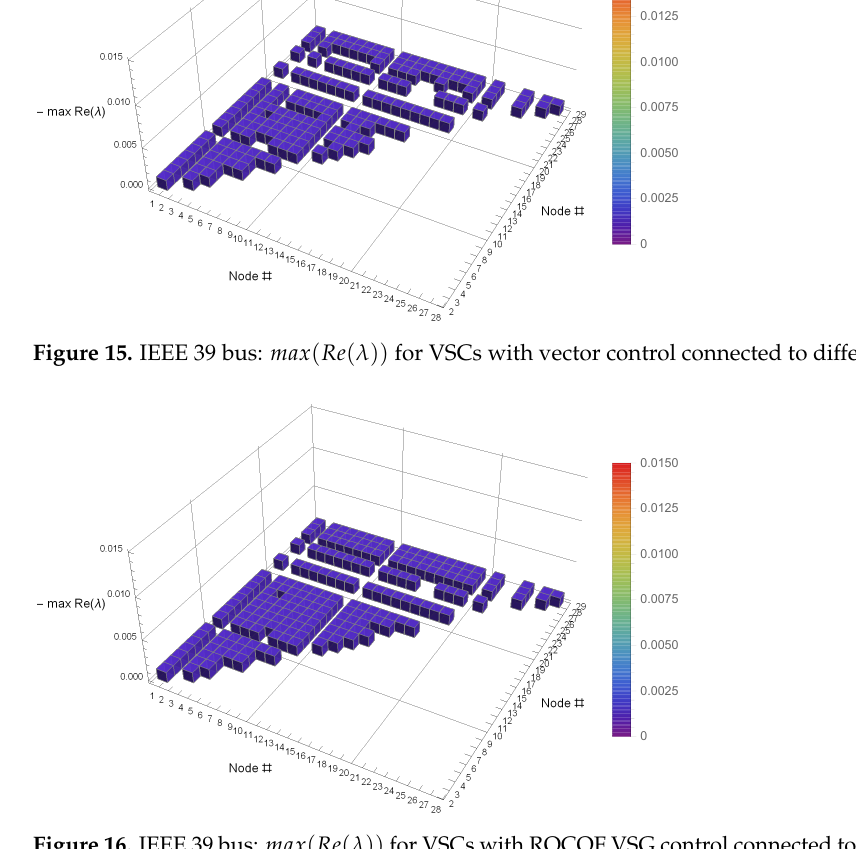
Figure 16. IEEE 39 bus: max ( Re ( λ )) for VSCs with ROCOF VSG control connected to different nodes.